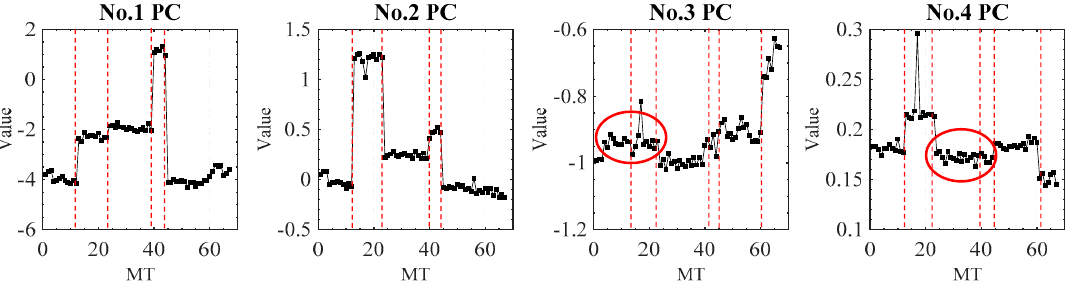
Figure 7. Variation tendency of the new PCs indicating machine tool with five states, MT stands for the